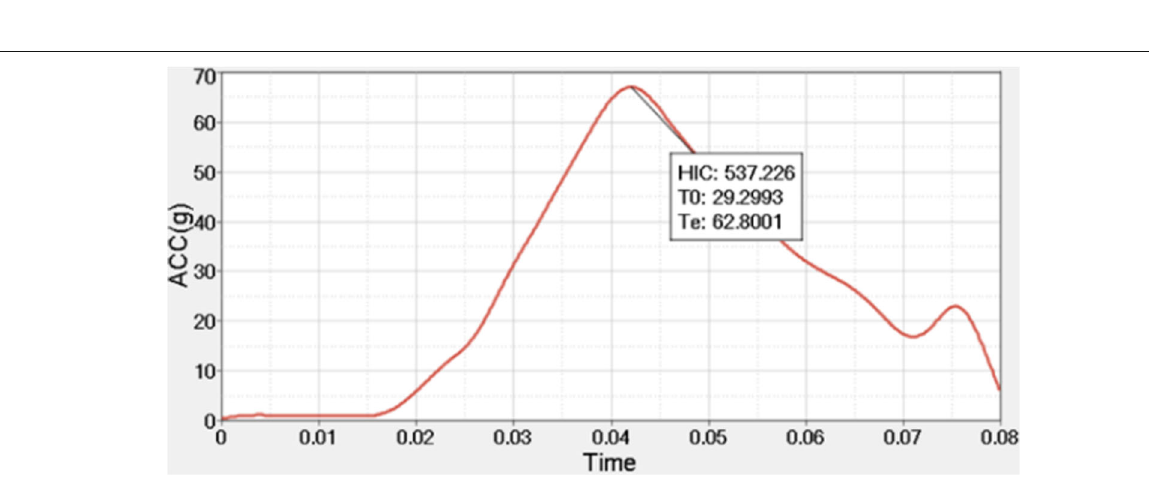
Fig. 17 The result of a head injury value with the airbag protection at the opening angle of